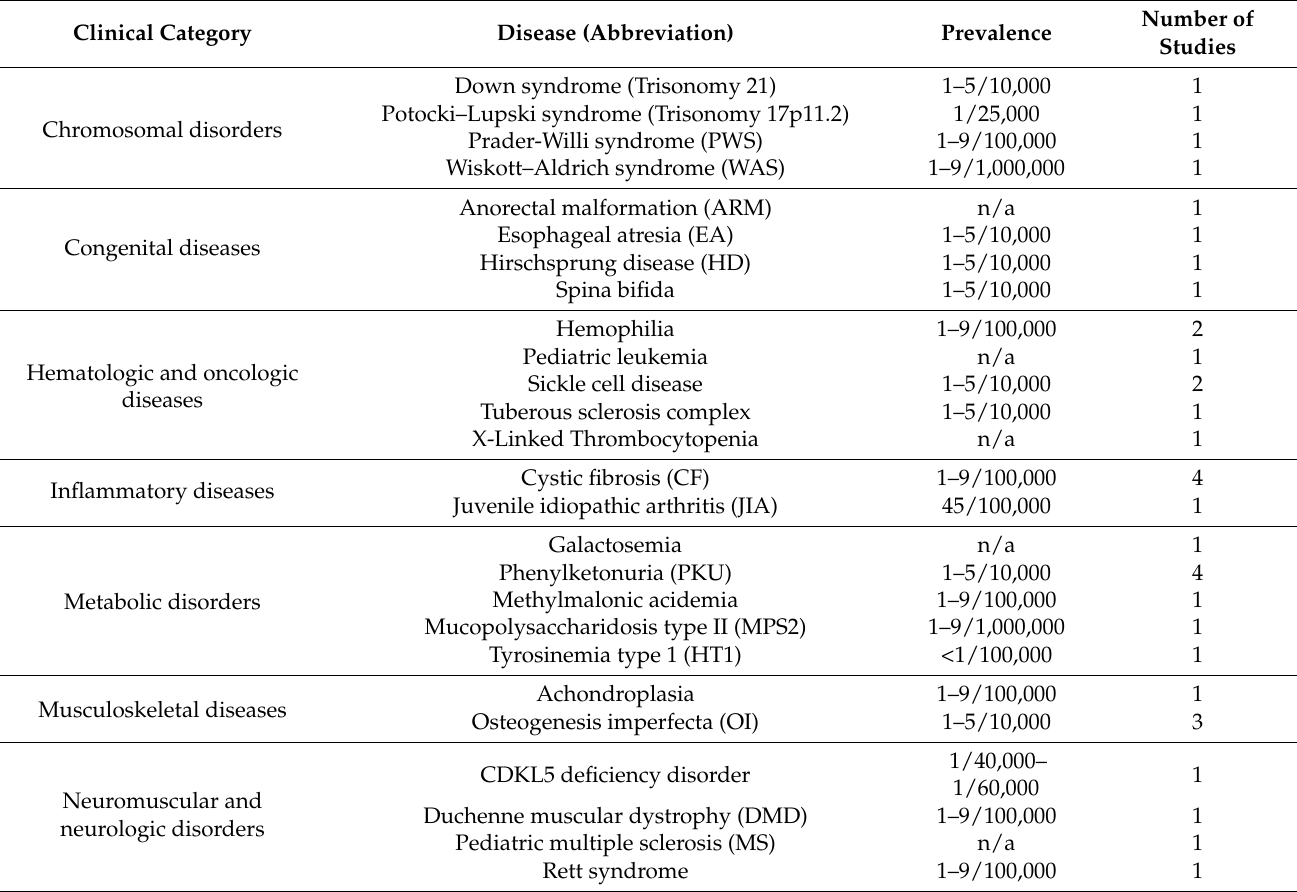
Table 2. List of rare diseases by clinical category.